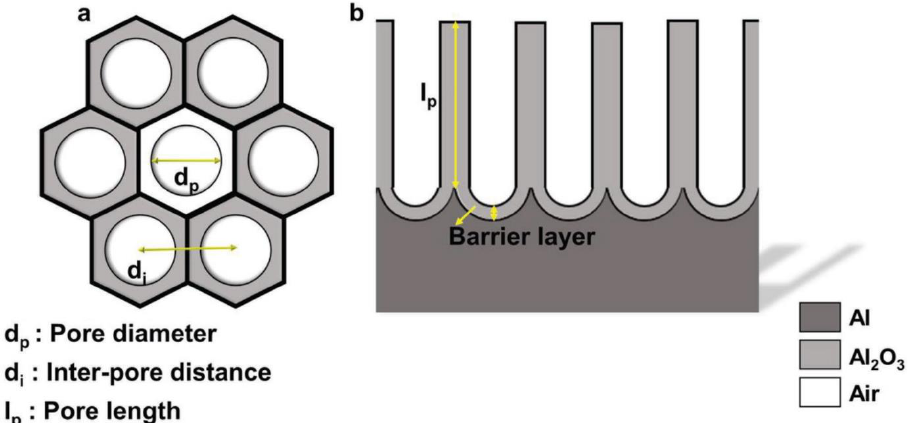
Figure 1. Schematic representation of nanoporous anodic alumina (NAA) structure. ( a ) Top-view with defined geometrical parameters; ( b ) cross-section with chemical composition. Reprinted with permission from [12]. Copyright 2017 Wiley.